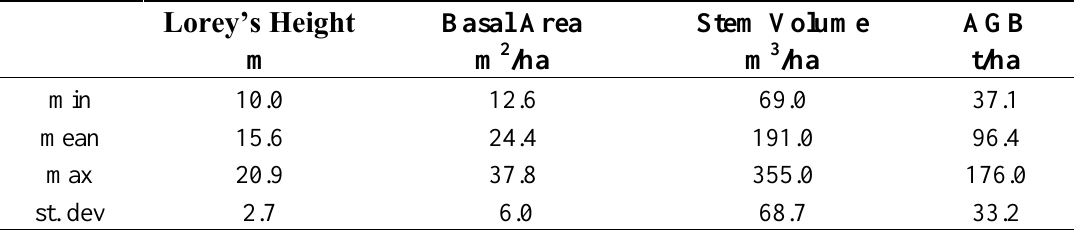
Table 2. The stand attributes predicted using airborne laser scanning (ALS)